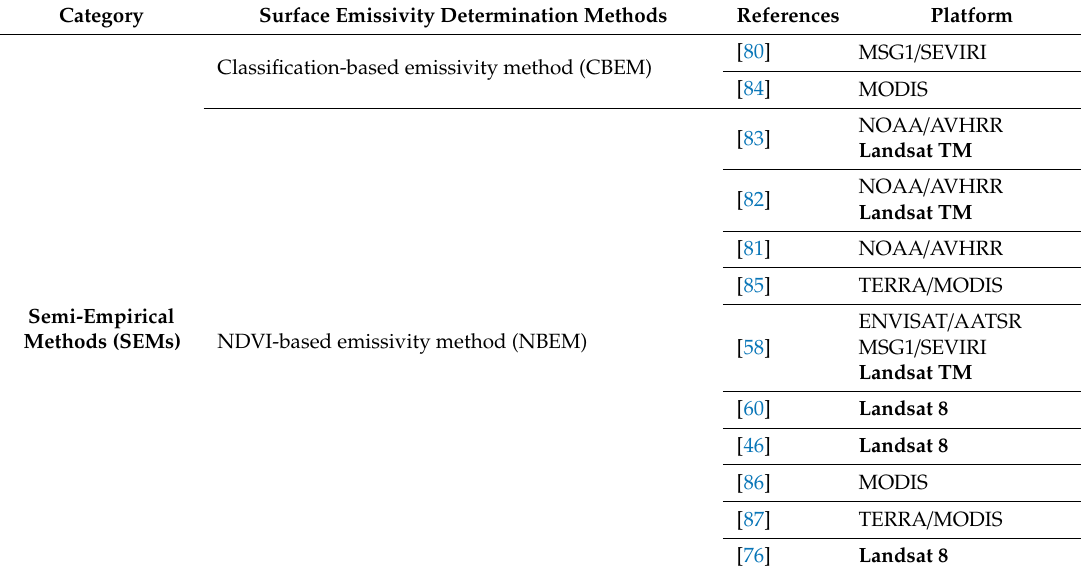
Table 3. The state-of-art table showing di ff erent LSE categories, LSE models, and the corresponding satellite missions